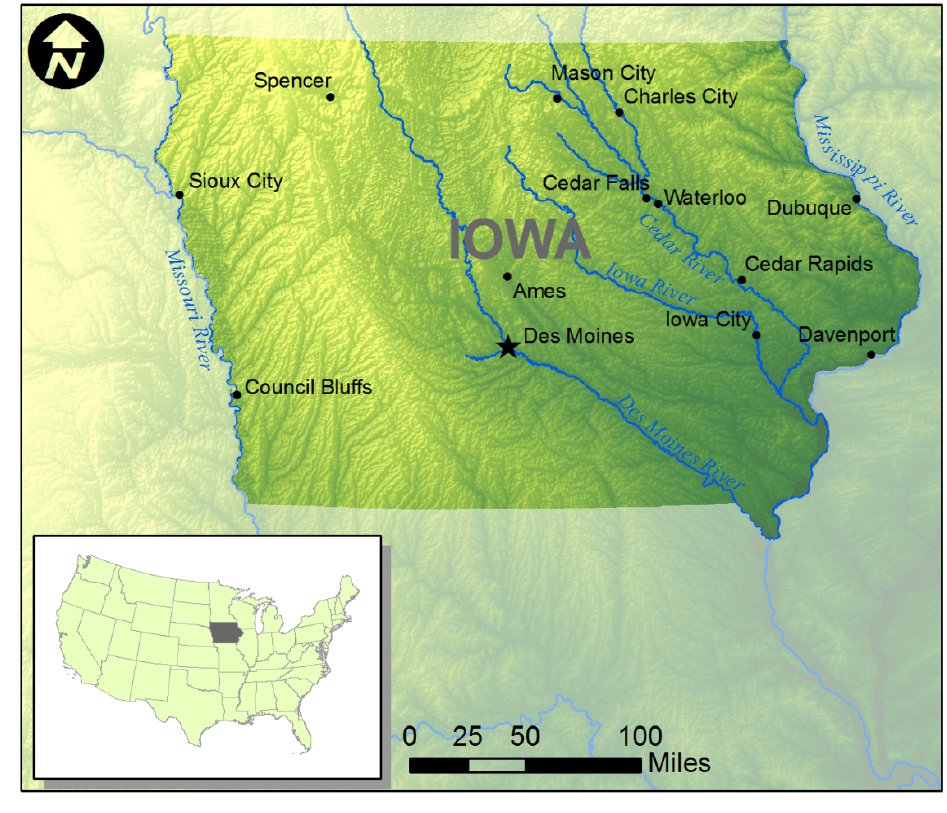
Figure 2. The state of Iowa located in the Midwestern United States. Most of Iowa’s major cities are located along